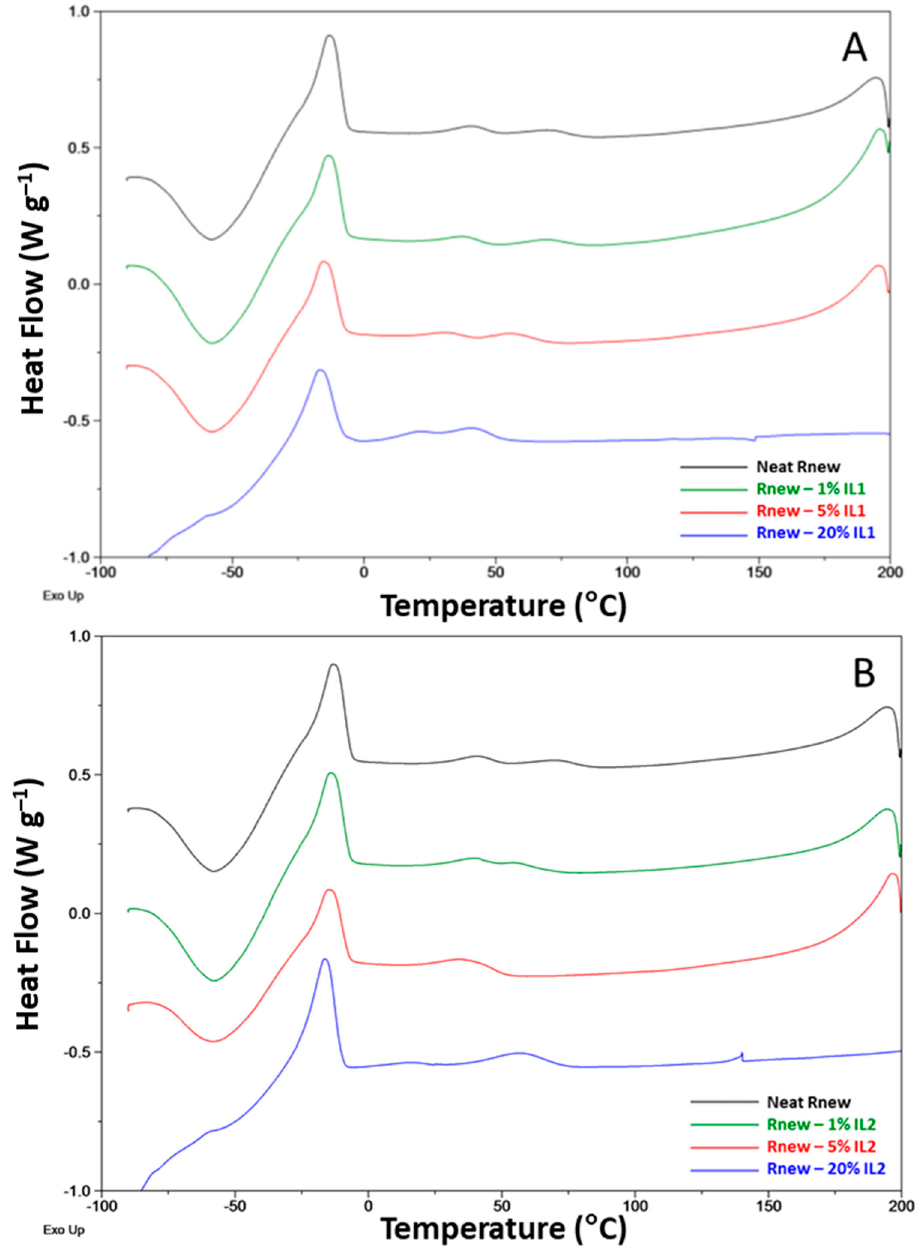
Figure 8. DSC traces for neat Pebax ® Rnew and Pebax ® Rnew composite membranes. Cooling scan. ( A ) Samples containing IL1 (HdmimDMSIP); ( B ) Samples containing IL2 (OOMmimPF 6 ).